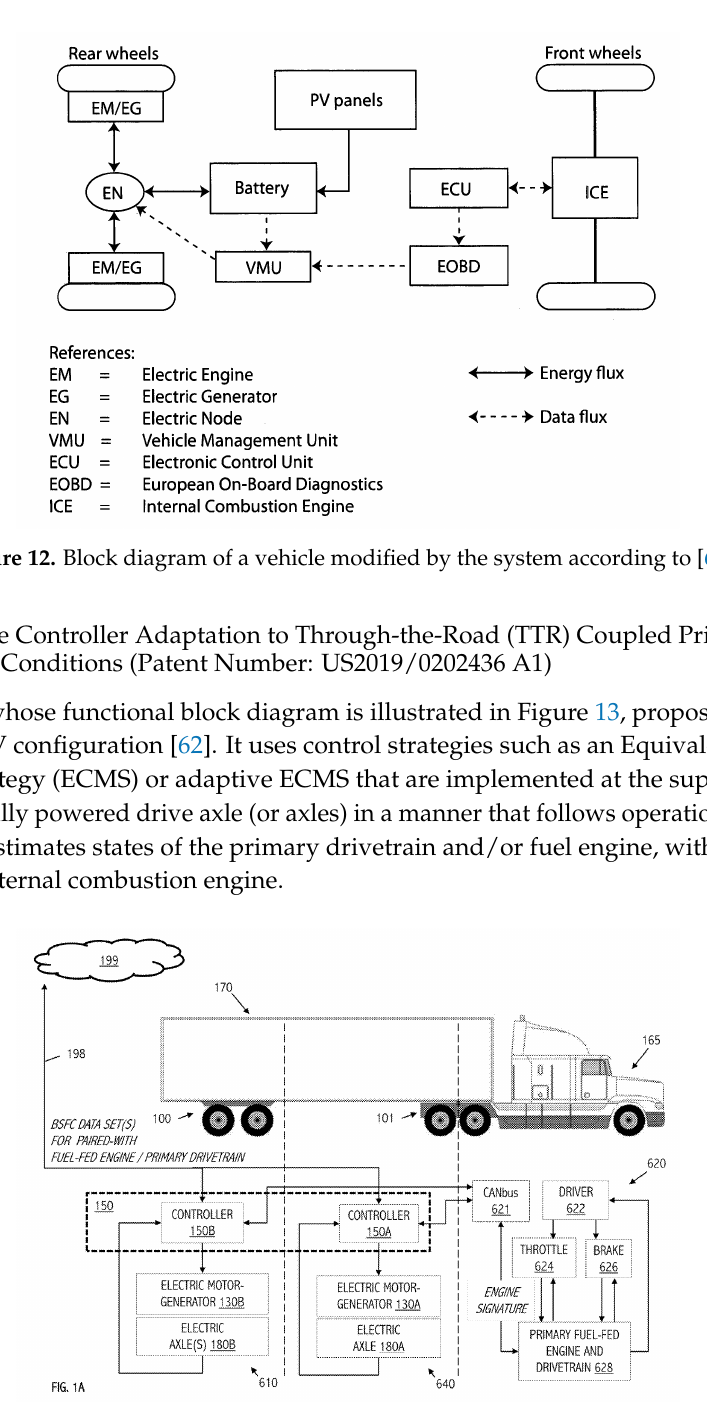
Figure 13. Functional block diagram illustrating hybridizing control